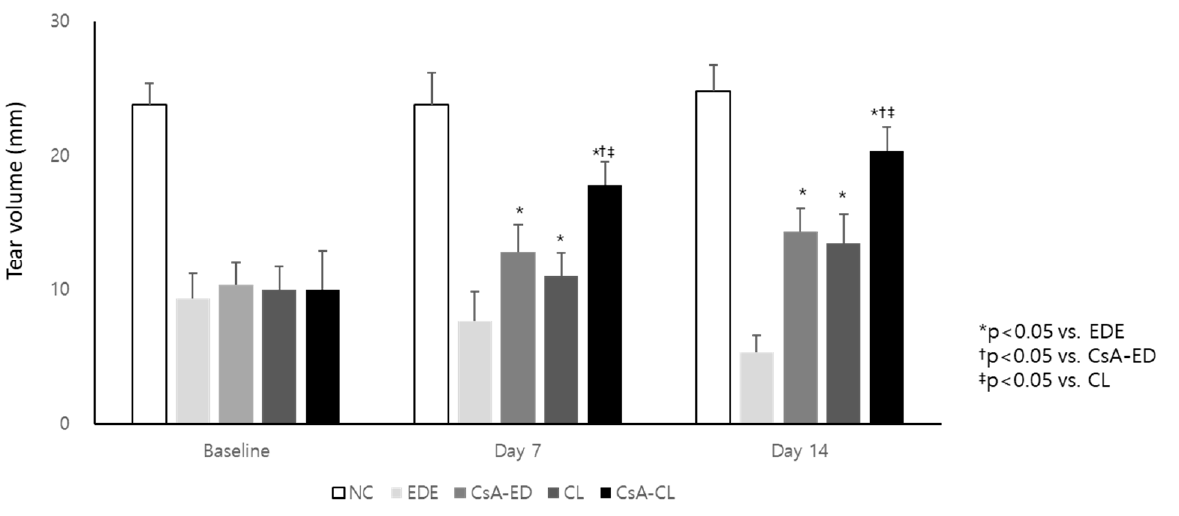
Figure 3. The tear volume at baseline and after 7 and 14 days of treatment. All data are presented as mean and SD. NC: normal control; EDE: experimental dry eye; CsA-ED: cyclosporine A eye drop; CL: contact lens; CsA-CL; cyclosporine A-loading pH-responsive contact lens. There were no statistically significant differences in the tear film break-up time (TBUT) among the groups except for the NC group at baseline. The mean TBUT at 7 and 14 days significantly decreased in the EDE group (4.38 ± 0.41 and 3.79 ± 0.48 s) compared to the NC group (8.49 ± 0.84 mm and 8.53 ± 0.93 mm; p < 0.01). The mean TBUT of the treatment groups at 7 and 14 days were 5.54 ± 0.44 and 6.26 ± 0.51 s in the CsA-ED group, 5.38 ± 0.44 and 6.02 ± 0.45 s in the CL group, and 6.85 ± 0.48 and 7.33 ± 0.54 s in the CsA-CL group, respectively (Figure 4). The CsA-ED, CL, and CsA-CL groups showed significantly longer TBUTs compared to the EDE group at 7 and 14 days (all p < 0.05). The values were higher in the CsA-CL group compared to the CsA-ED and CL group at 7 and 14 days (all p < 0.05). TBUT significantly improved at day 7 and 14 compared to the baseline in all treatment groups (all p < 0.05).